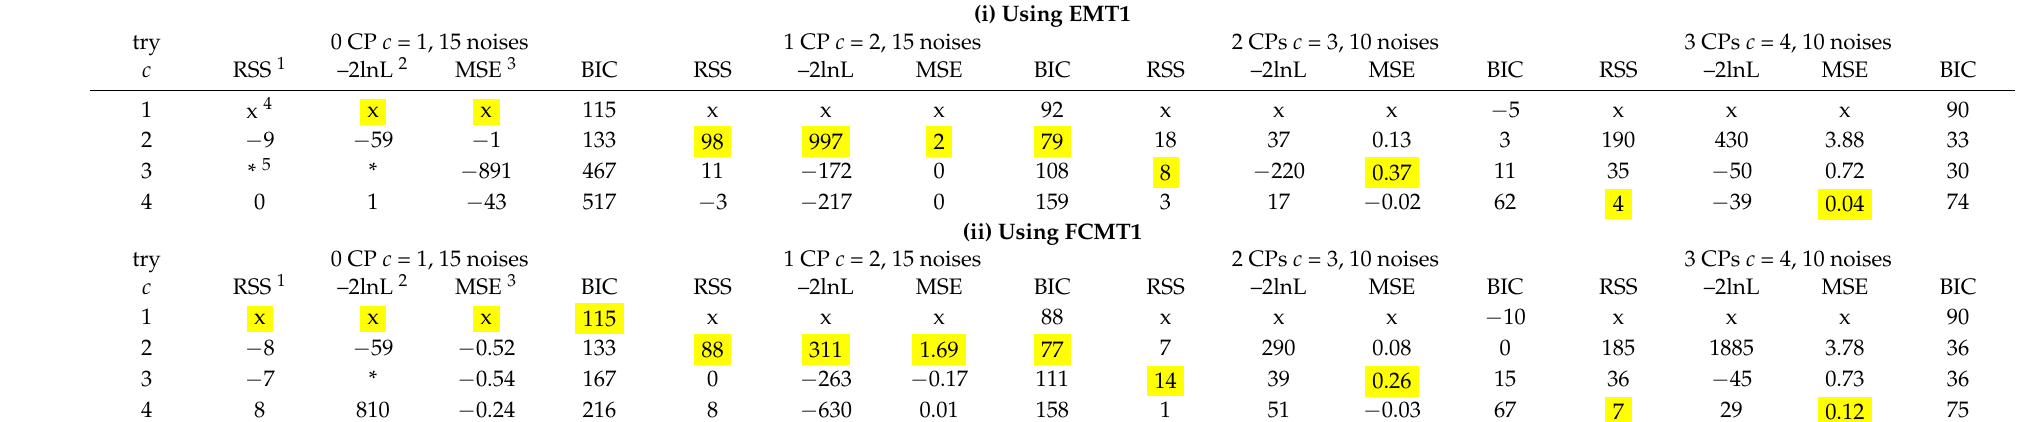
Table 5. Deciding the number of segments for the models in Figure